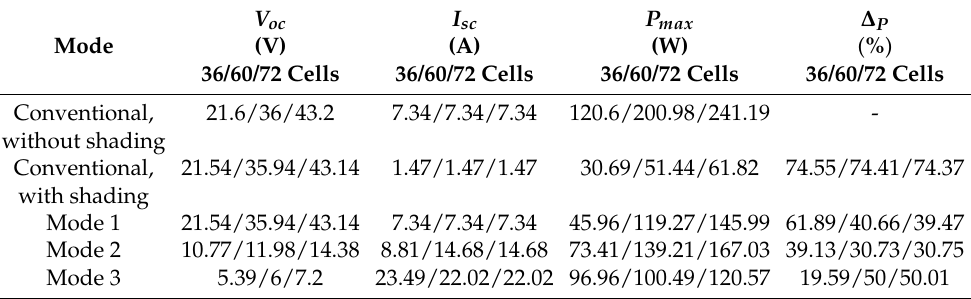
Table 2. Electrical parameters of PV modules for five